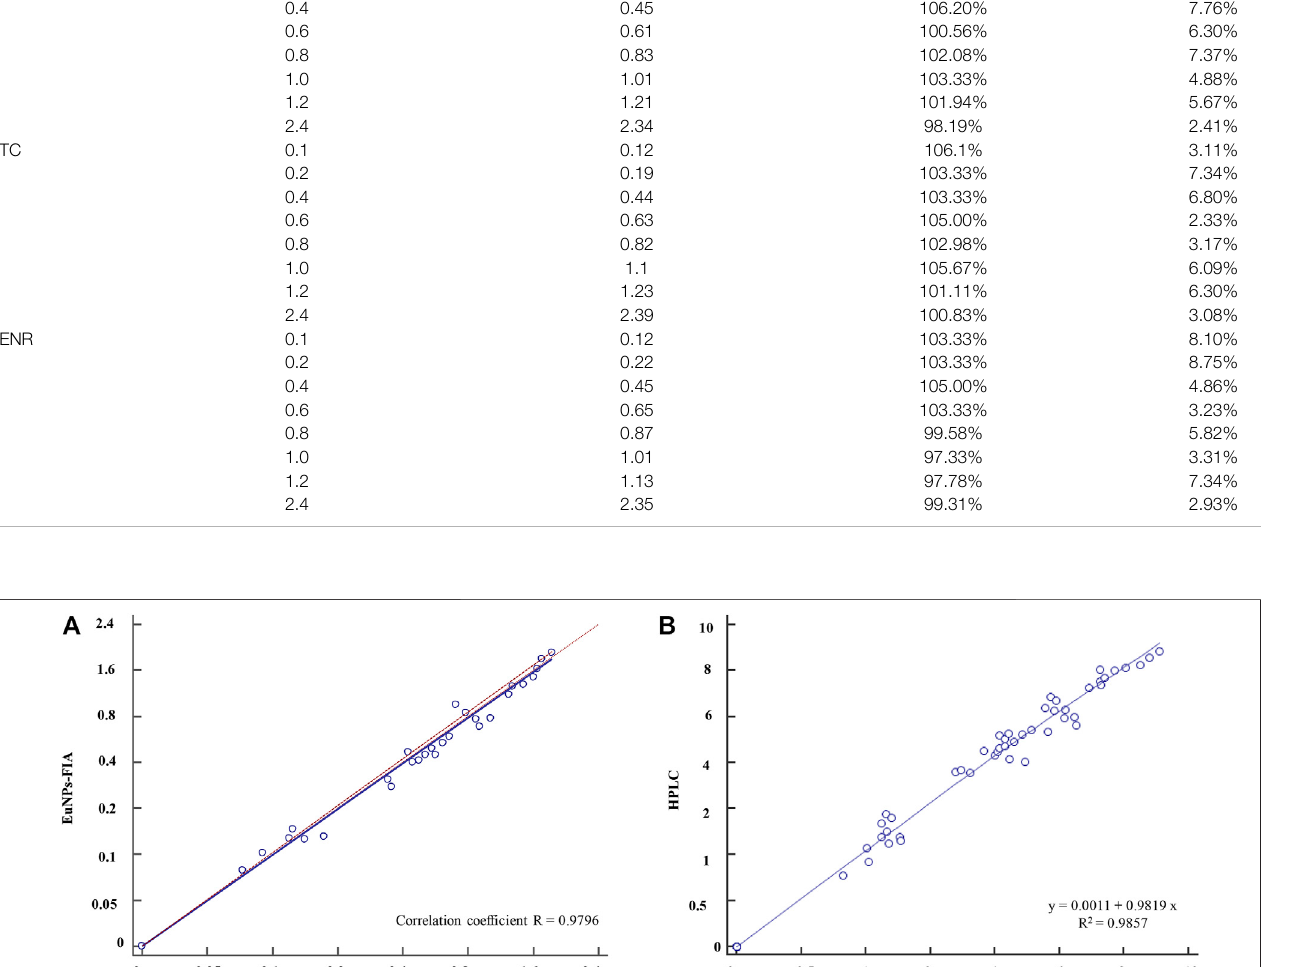
Frontiers in Chemistry |